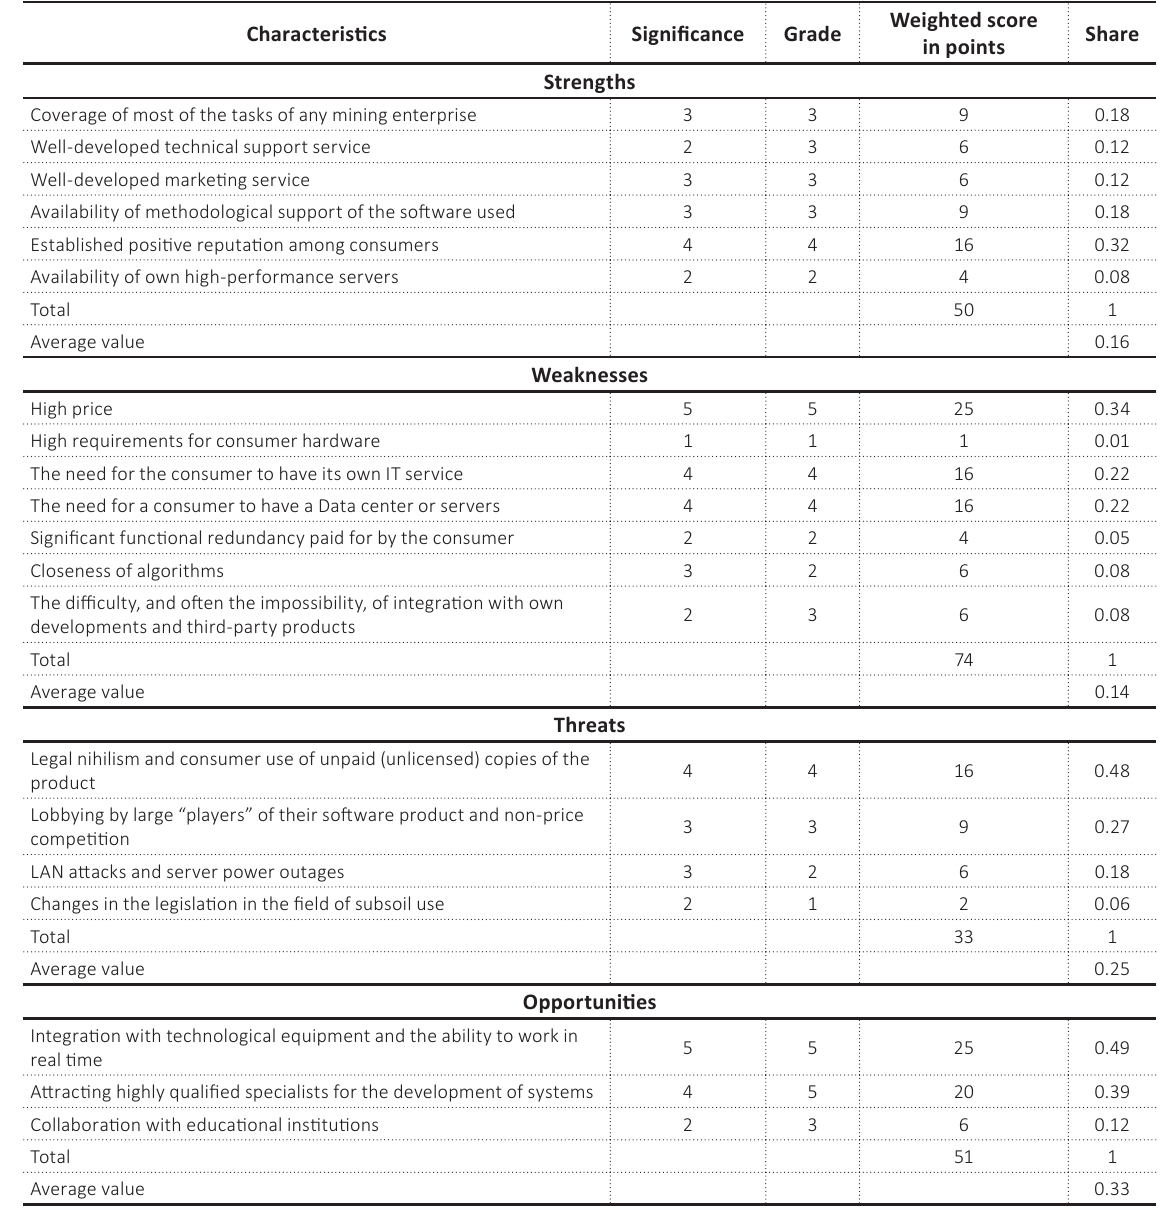
Table 1. Strengths and weaknesses of competing programs